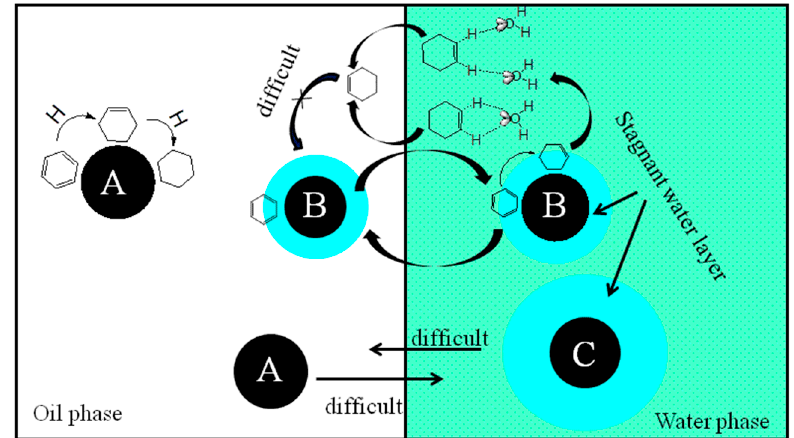
Figure 7. Two types of hydrogen bond formed between cyclohexene and water molecules, as well as the hydrogenation scheme both in the oil phase and aqueous phase, over Ru-Zn/ZrO 2 catalysts with different wettability.